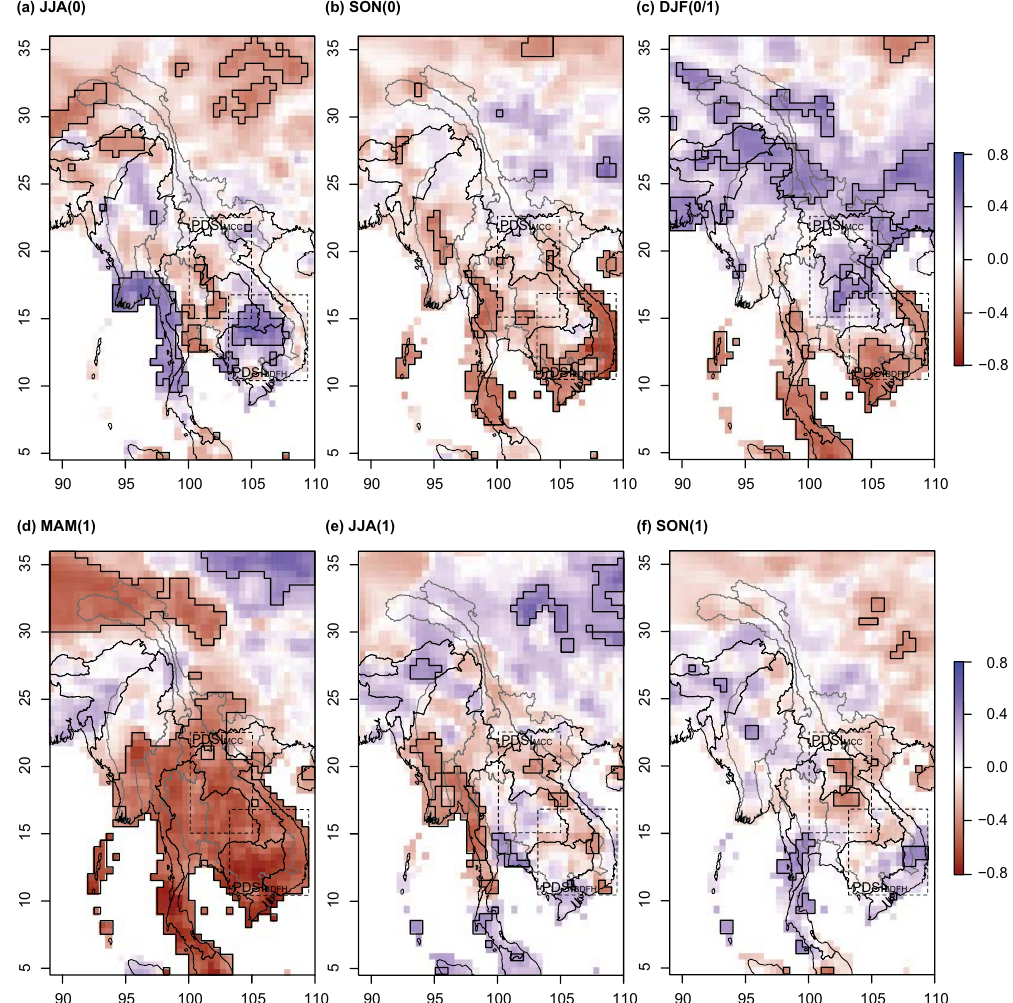
Figure 2. Map of correlation of January–February–March values of multivariate ENSO index (MEI JFM ) and seasonal precipitation over the period of 1980–2013: (a) June–July–August (JJA (0)), (b) September–October–November (SON(0)), (c) December–January–February (DJF(0/1)), (d) March–April–May (MAM(1)), (e) June–July–August (JJA (1)), and (f) September–October–November (SON(1)). “0” de- notes the first (i.e. developing) year, and “1” denotes the second (i.e. decaying) year of ENSO events. Black lines delimit areas of